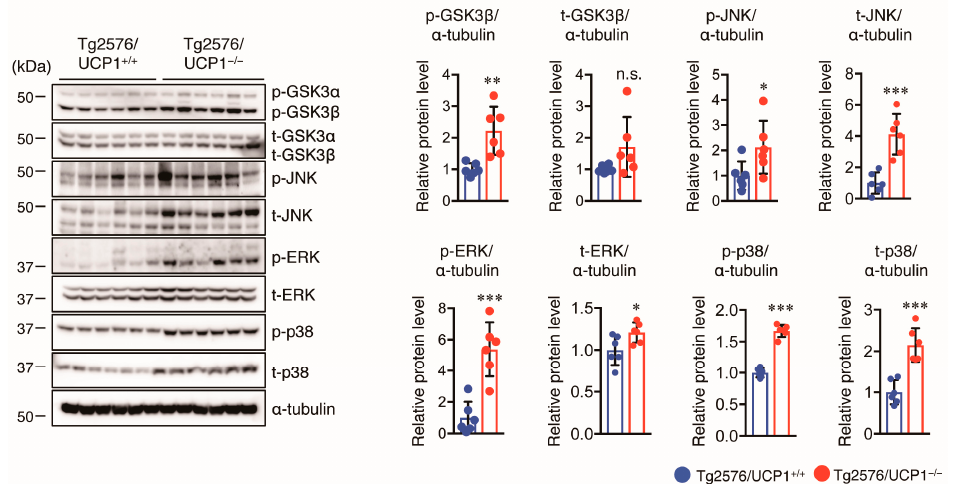
Figure 5. UCP1 deletion in Tg2576 mice enhances the phosphorylation of tau kinases. Representative immunoblots showing the cortical levels of total (t-) and phosphorylated-(p-) GSK3 α / β , JNK, ERK, p38, and α -tubulin in 17-month-old Tg2576/UCP1 +/+ and Tg2576/UCP1 -/- mice (left panel). Relative protein levels quantified by densitometry (right panels). The results shown are mean ± SD, n = 6 for each group, * p < 0.05, ** p < 0.01, *** p < 0.001 vs. Tg2576/UCP1 +/+ , n.s., no significant difference, as determined by Student’s t -test.